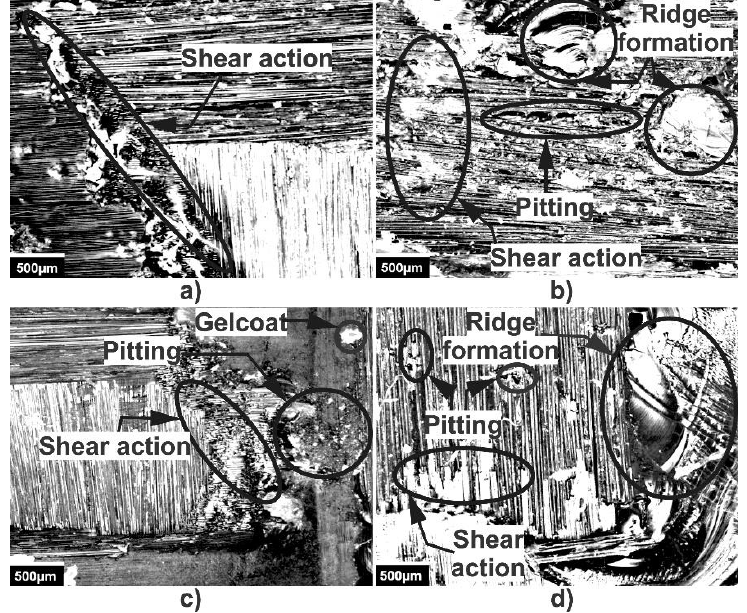
Figure 8. Wear mechanisms by water erosion in ( a ) carbon fiber, ( b ) glass fiber, ( c ) carbon fiber with Gelcoat and ( d ) glass fiber with Gelcoat.